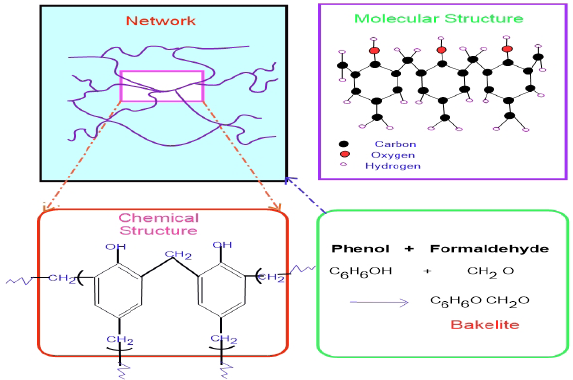
Figure 1: Structural phases of Bakelite.